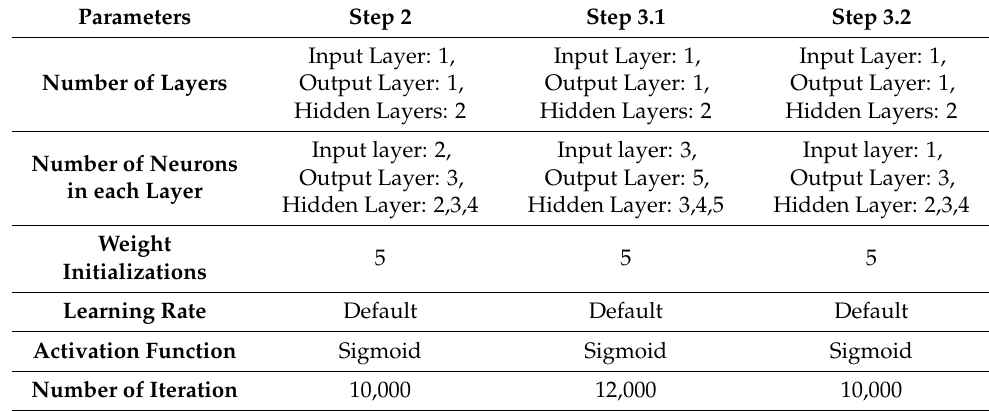
Table 4. Parameters of the ANN model for all PSPP spaces.